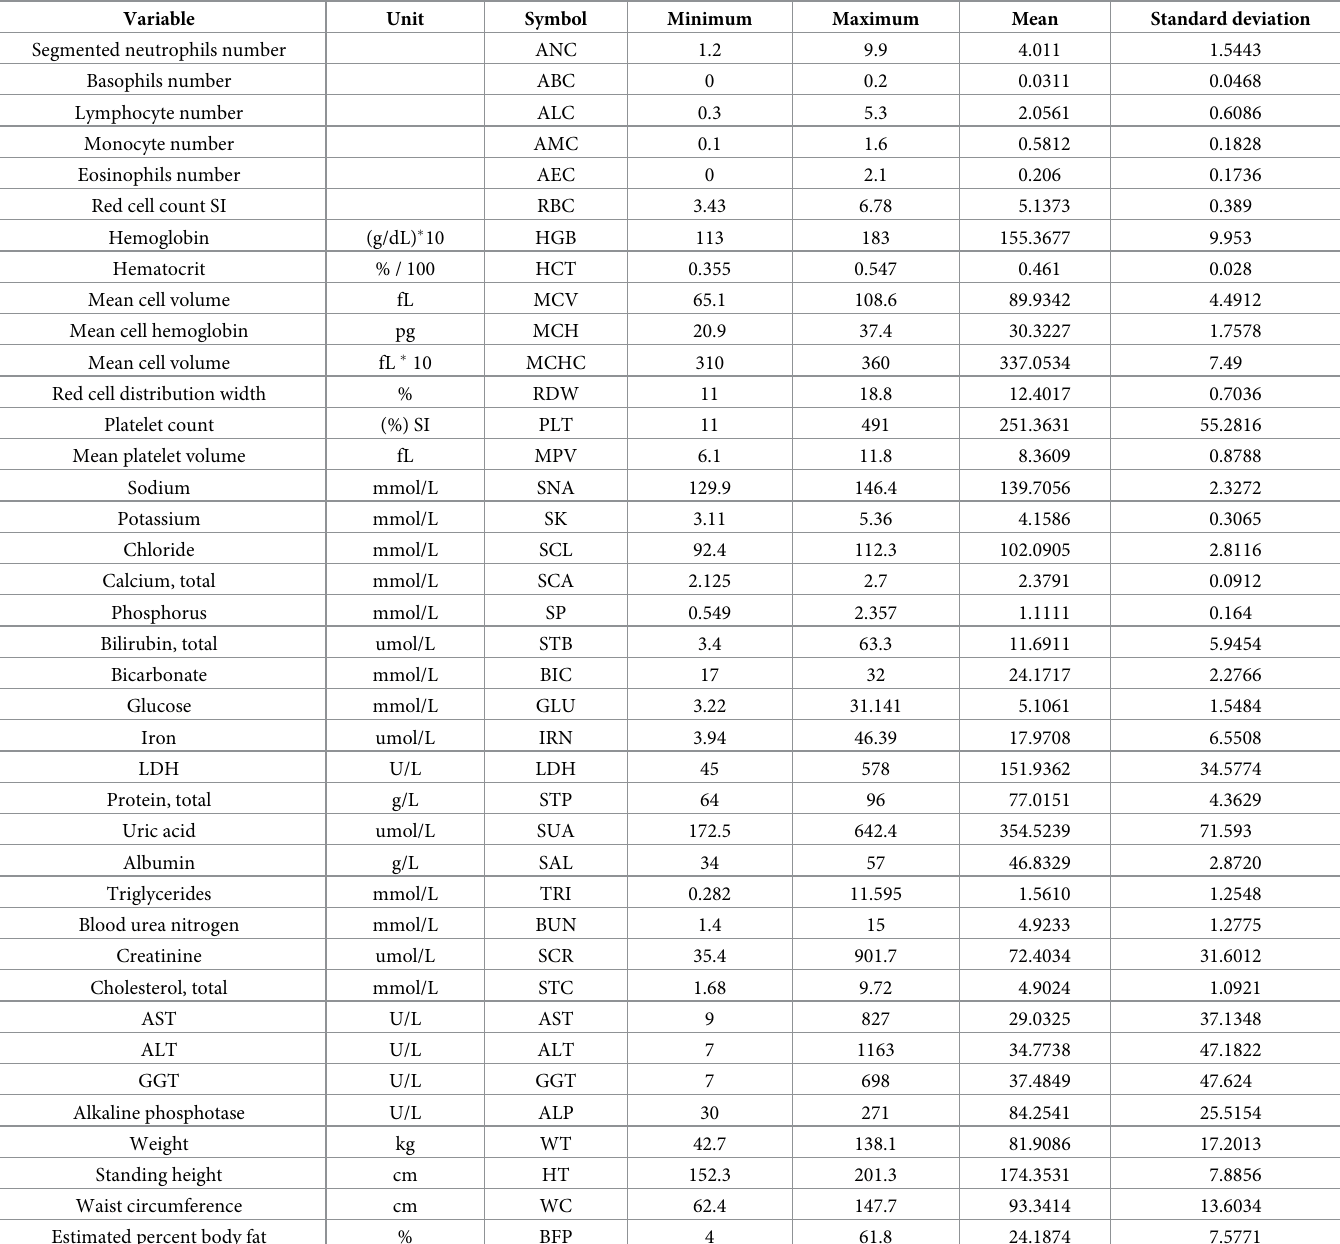
Table 8. Statistical properties of Case 2’s body fat dataset. More details can be found at